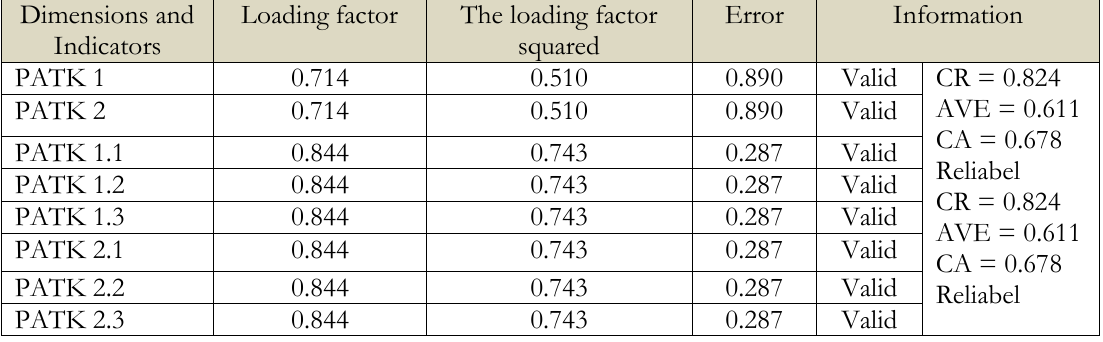
Recapitulation of Dimension Results and Indicators for decreasing labor figures Dimensions and Dimensions